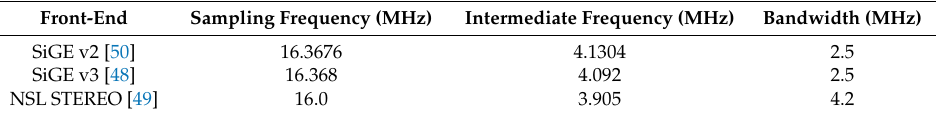
Table 1. FEs supported by NGeneApp.